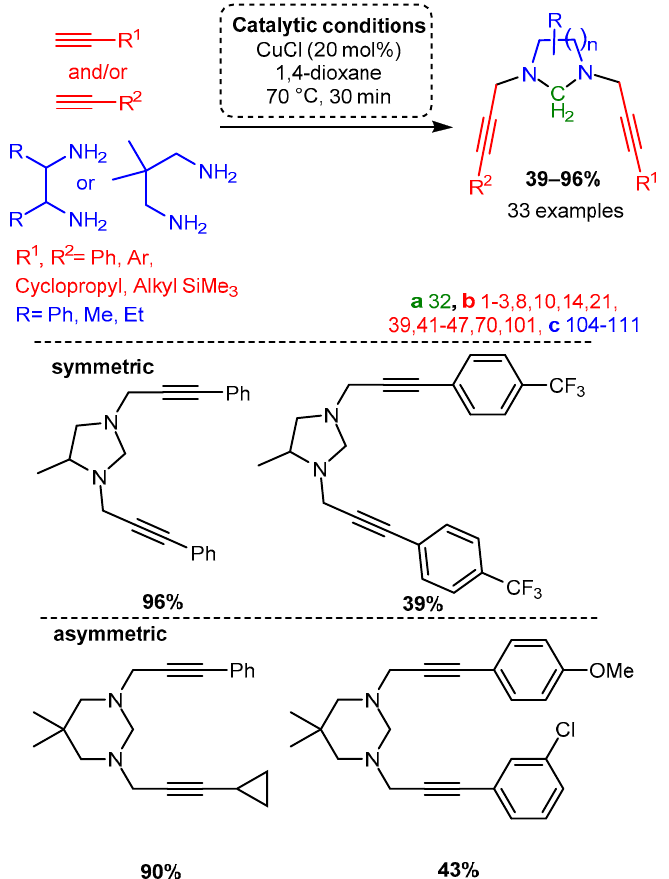
Scheme 8. Formation of cyclic divalent PAs from diamines with the appropriate component choice. Chemoselective alkynylation forms unsymmetrical